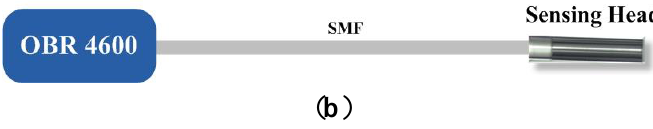
Figure 4. Illustration of the experimental setups used to characterize the Fabry-Pérot interferometer. ( a ) Using a broadband light source; ( b ) Using an optical backscatter reflectometer (OBR).